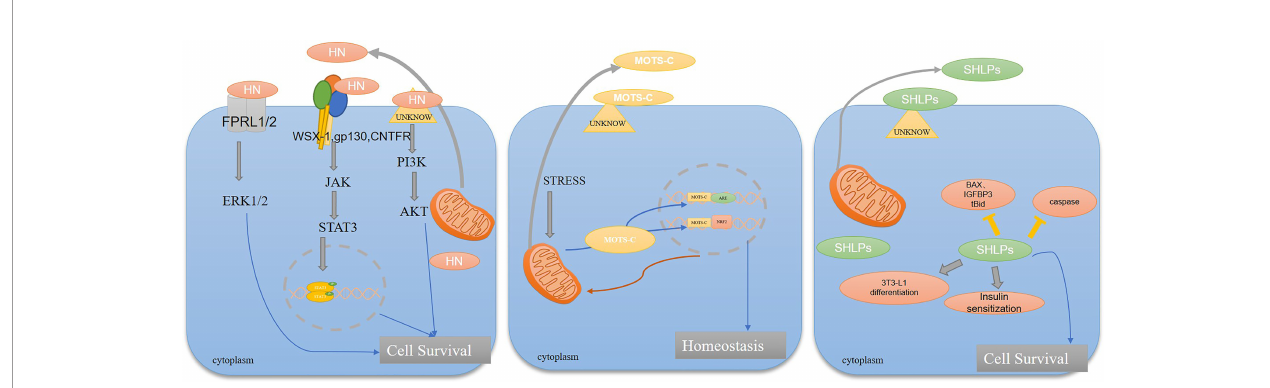
FIGURE 1 | Role of mitochondria derived peptides in cells and their regulation of related diseases. HN acts by activating formylpeptide-like receptors (FPRL) and heterotrimeranthroinin receptors composed of GP130 ciliated neurotrophic factor receptor (CNTFR) and WSX-1. In addition, HN promotes phosphorylated STAT3 dimer entry into the nucleus to regulate gene transcription and activates the FPRL1/2-ERK1/2 pathway to play a protective role in cell. MOTS-c translocates to the nucleus in a 5 ’ -adenosine monophosphat-activated protein kinase (AMPK) -dependent manner after metabolic stress. MOTS-c regulates a wide range of genes in response to glucose restriction, including genes with antioxidant response elements (ARE), and interacts with stress response transcription factors that regulate ARE, such as the nuclear factor erythrocyte 2-associated factor 2 (NFE2L2/NRF2), to enhance mitochondrial function and thus maintain cellular homeostasis. SHLPs can enhance insulin sensitivity, promote adipocyte 3T3-L1 differentiation, inhibit the expression of caspase and ROS, and play a cellular protective